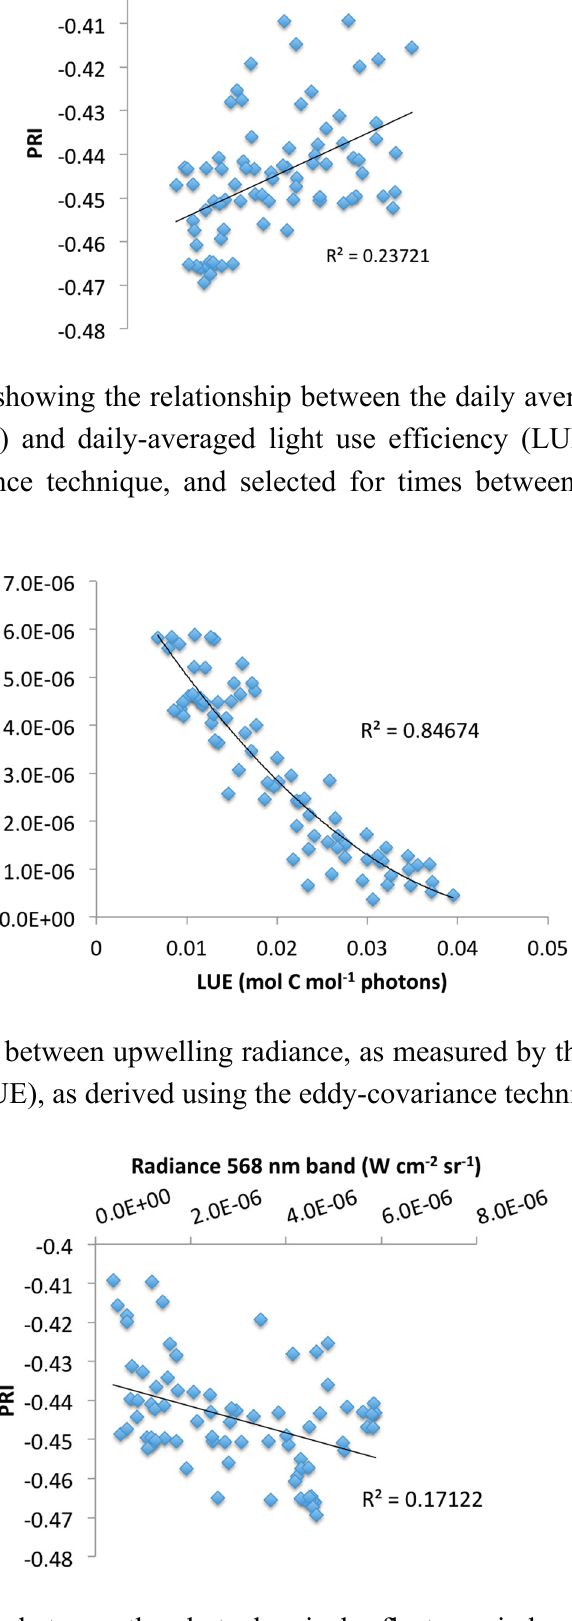
Figure 10. Relationship between the photochemical reflectance index (PRI) and upwelling radiance measured in the reference band (568